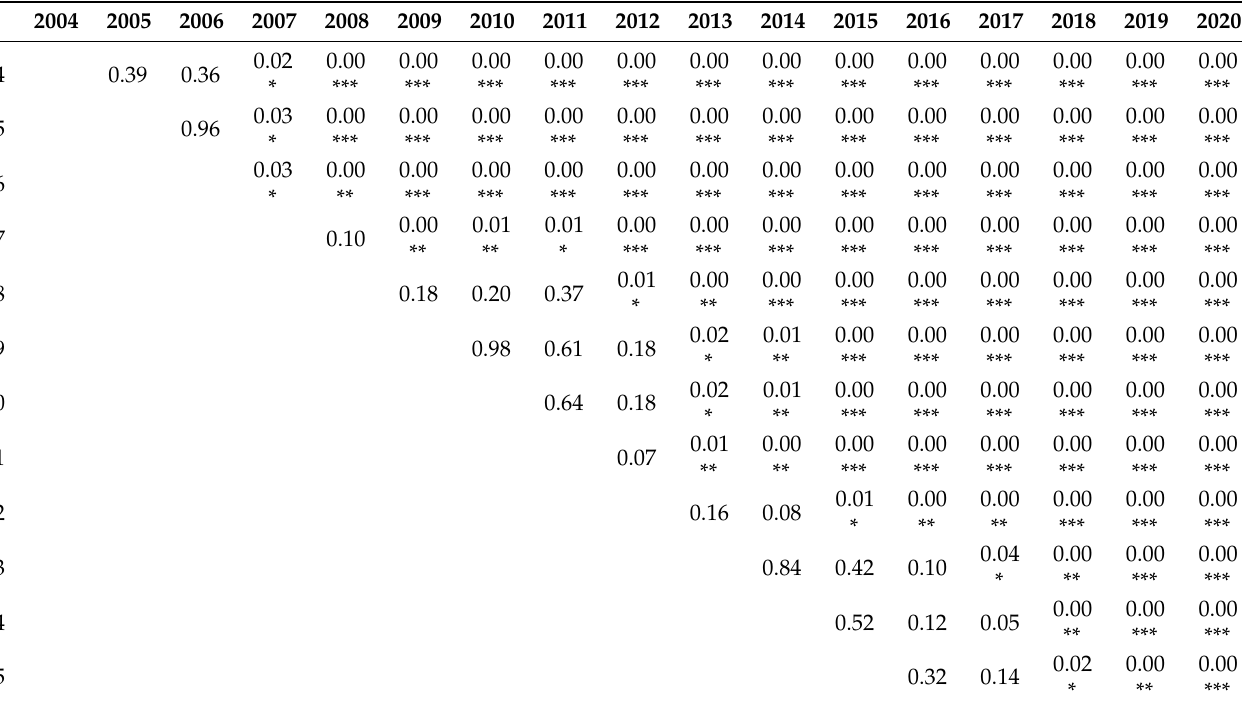
Table 3. t -test for Homoscedasticity in Two Tails for Indemnity Series, 2004 to